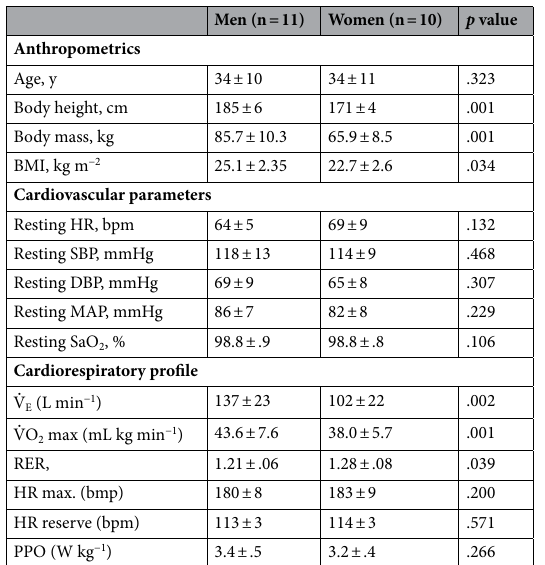
Table 1. Characteristics of the participants included. BMI body mass index, HR heart rate, SBP systolic blood pressure, DBP diastolic blood pressure, MAP mean arterial pressure, SaO 2 (%) oxygen saturation, ˙ V pulmonary ventilation, O 2 max . maximal oxygen uptake, RER respiratory exchange ratio, HRmax . maximal heart rate, PPO peak power output; Data are presented as mean ±